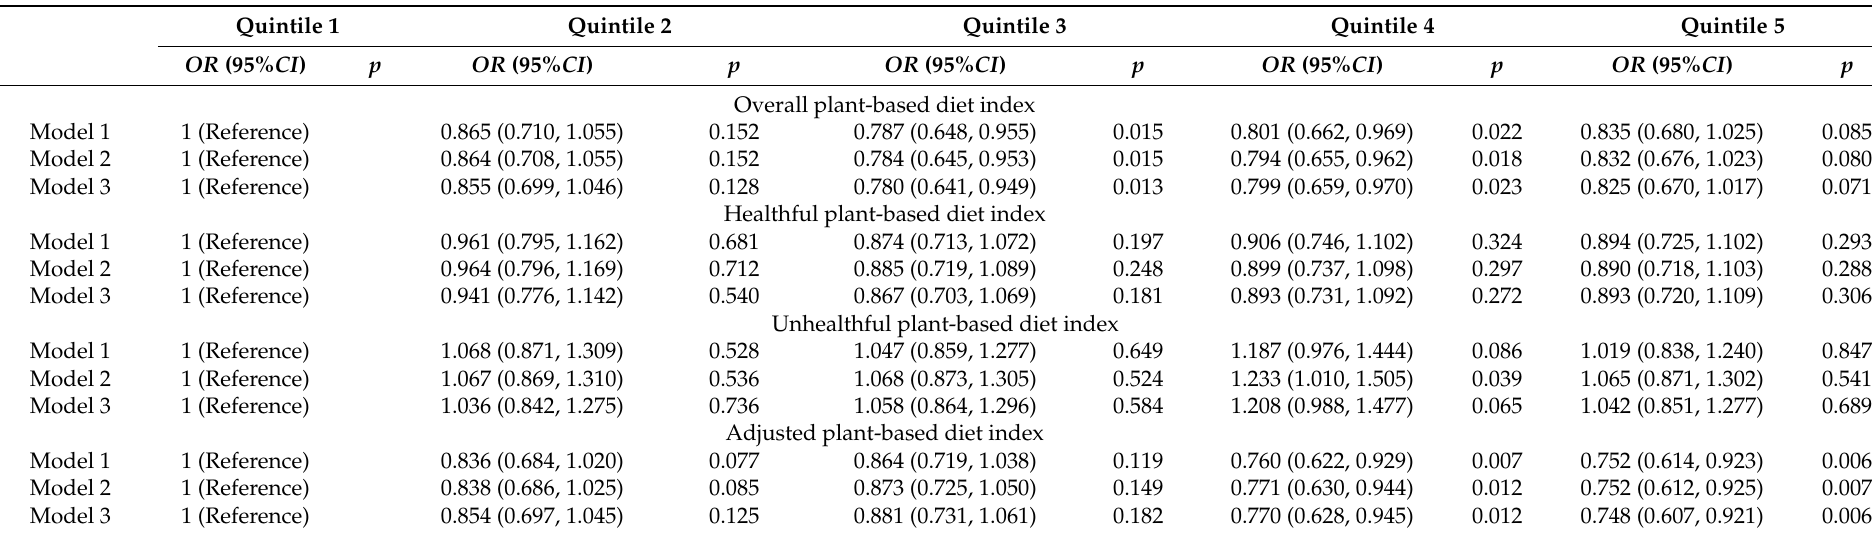
Table 2. Multivariate logistic regression analyses showing associations between dyslipidemia and quintiles of plant-based diet indices. Quintile 1 Quintile 2 Quintile 3 Quintile 4 Quintile